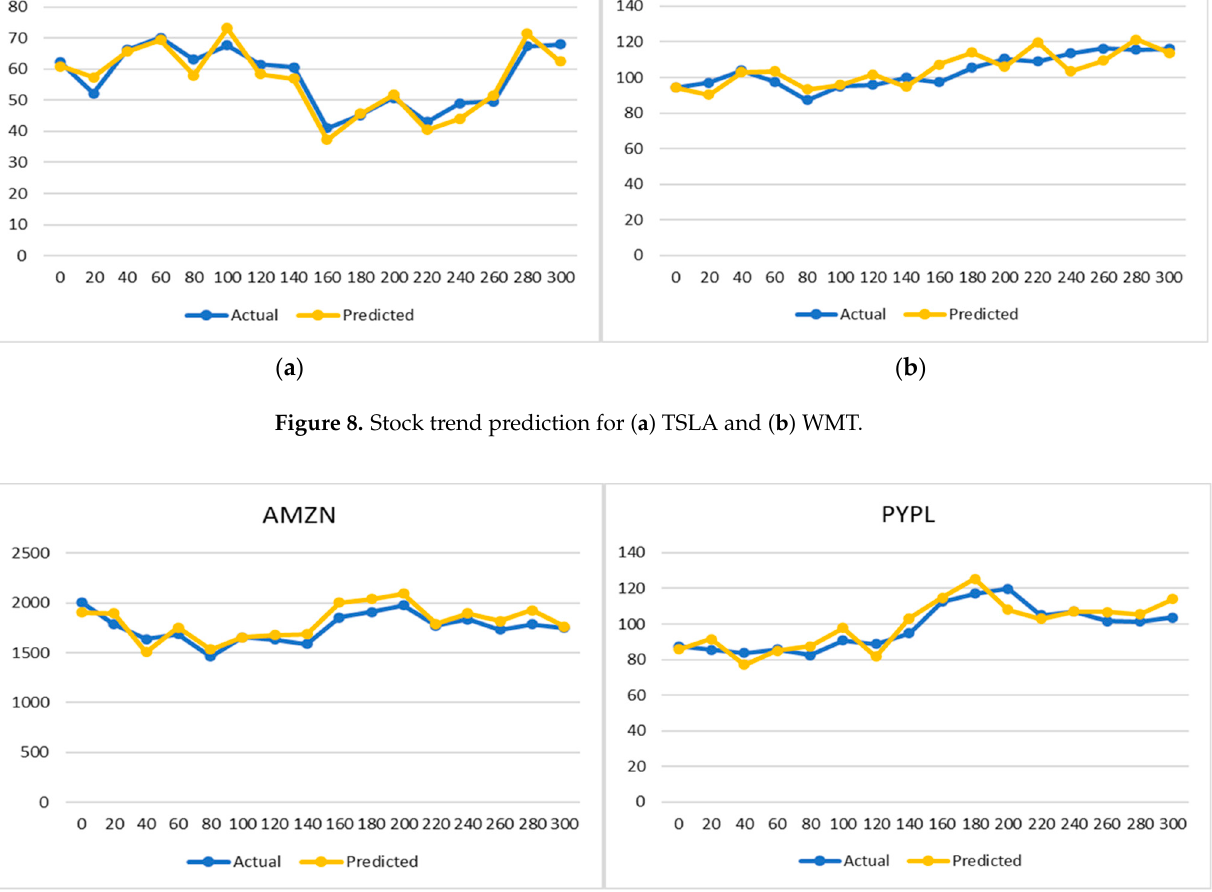
Figure 9. Future Price determination for ( a ) AMZN and ( b ) PYPL.